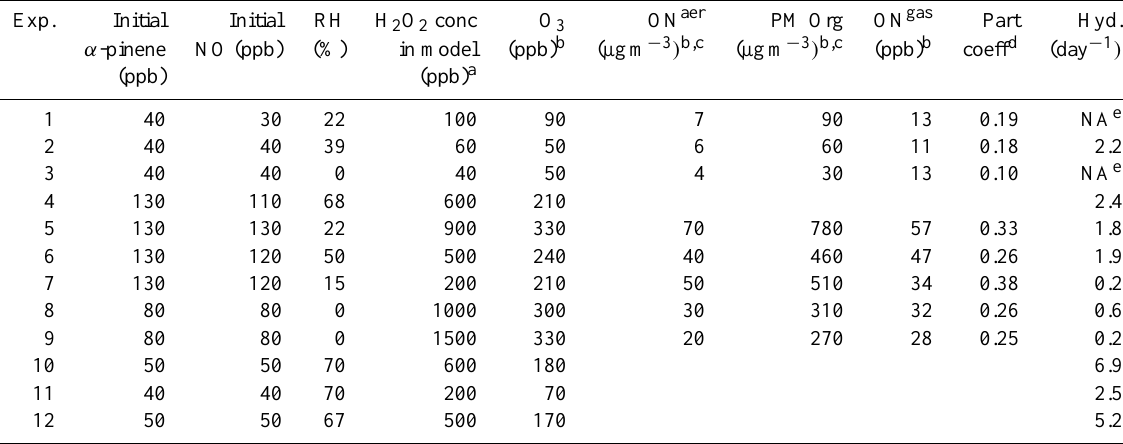
Table 1. Experimental conditions and summary of results. Exp.